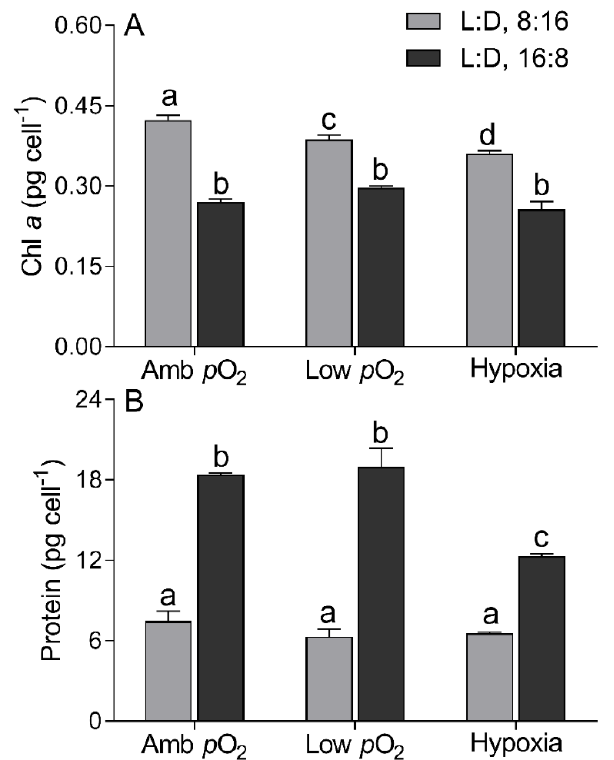
Figure 2. Chlorophyll a (( A ), Chl a , pg cell − 1 ) and protein contents (( B ), pg cell − 1 ) of T. pseudonana grown under 8:16 and 16:8 L:D cycles, under ambient p O 2 , low p O 2 , and hypoxia. The vertical bar shows the standard deviation ( n = 3), and different letters on top of the bar indicate the significant differences ( p < 0.05, one-way ANOVA).